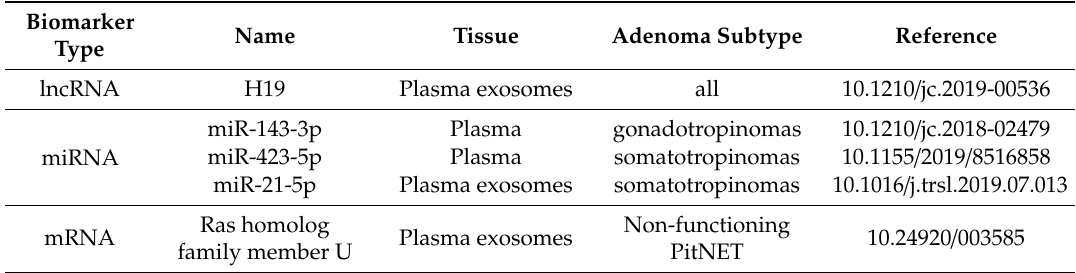
Table 1. cfRNA biomarkers for pituitary neuroendocrine tumors (PitNET) that have already been detected in liquid